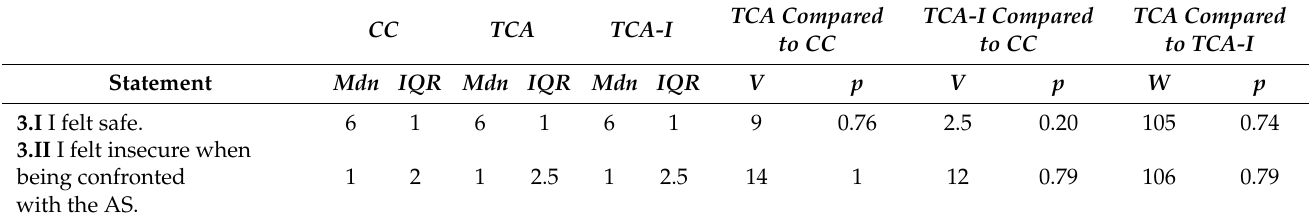
Table 4. Summary of pairwise comparisons for Wilcoxon signed rank test and Wilcoxon rank-sum test of statements concerning the participants’ sense of